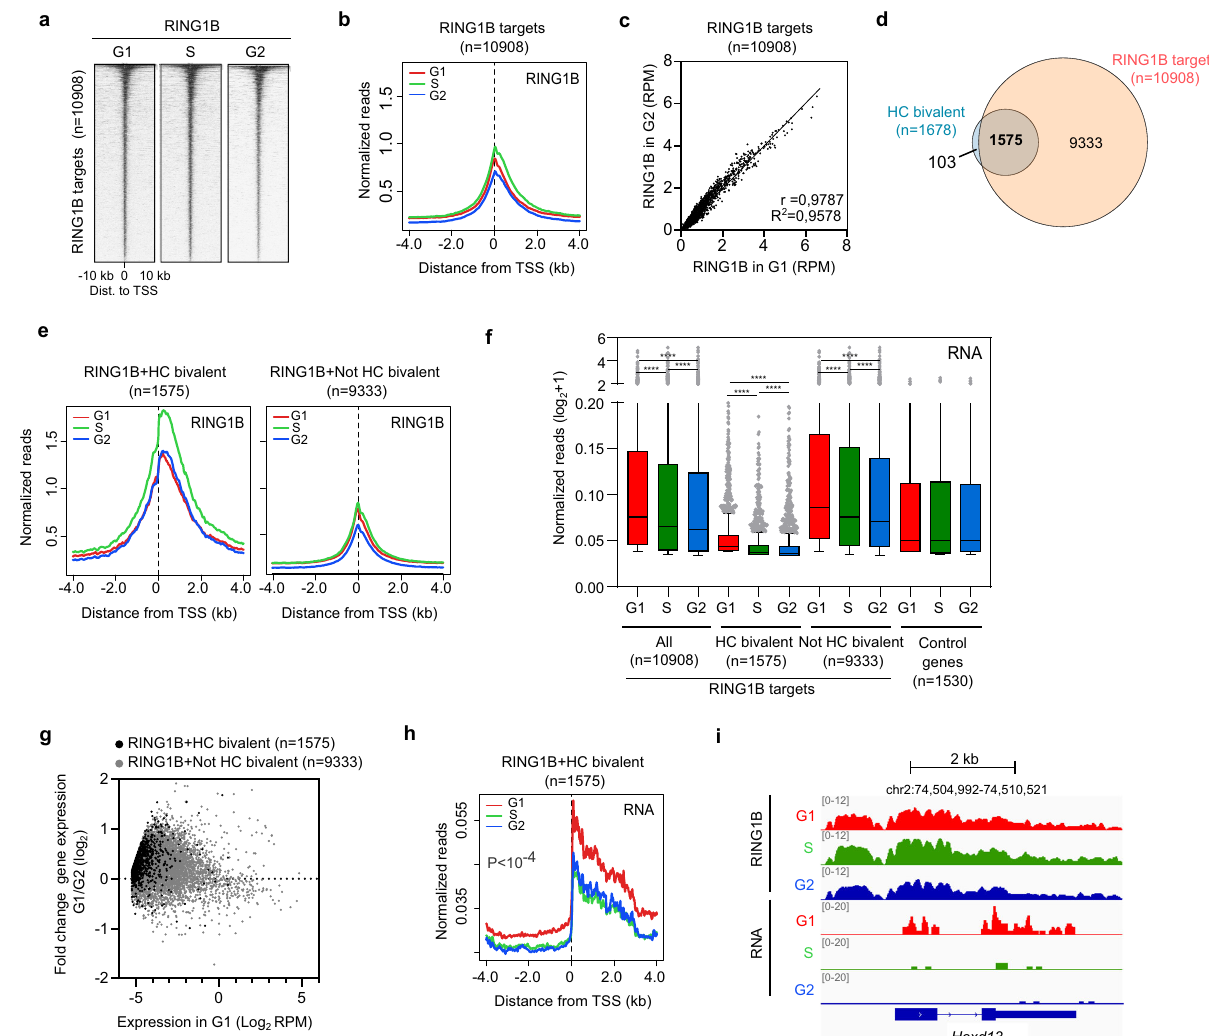
Fig. 1 | RING1B remains bound to target gene promoters across interphase. a HeatmapsofnormalizedRING1BChIP-seqreadsaroundtheTSS(±10kb)oftarget promoters ( n =10,908) at different phases of the cell cycle. Genes are ranked accordingtothesignalinG2phase. b Averagebindingpro fi leofRING1Baroundthe TSS of RING1B target promoters in G1 (red), S (green) and G2 (blue) phases. c Correlation analysis between the signal of RING1B binding around the TSS ( − 0.5kb to +1.5kb) of target genes during G1 ( x -axis) and G2 ( y -axis). Linear regression R 2 andPearsoncoef fi cient( r )areindicated. d Venndiagramshowingthe overlap between HC bivalent promoters (blue) and RING1B target promoters (orange). HC bivalent promoters were previously de fi ned 19 . e Average binding pro fi le of RING1B around the TSS of target genes that are HC bivalent promoters (left panel) or not (right panel) de fi ned in ( d ) in G1 (red), S (green), and G2 (blue) phases. f Boxplots comparing 4sU-seq RNA reads (RPM) mapped to the proximal